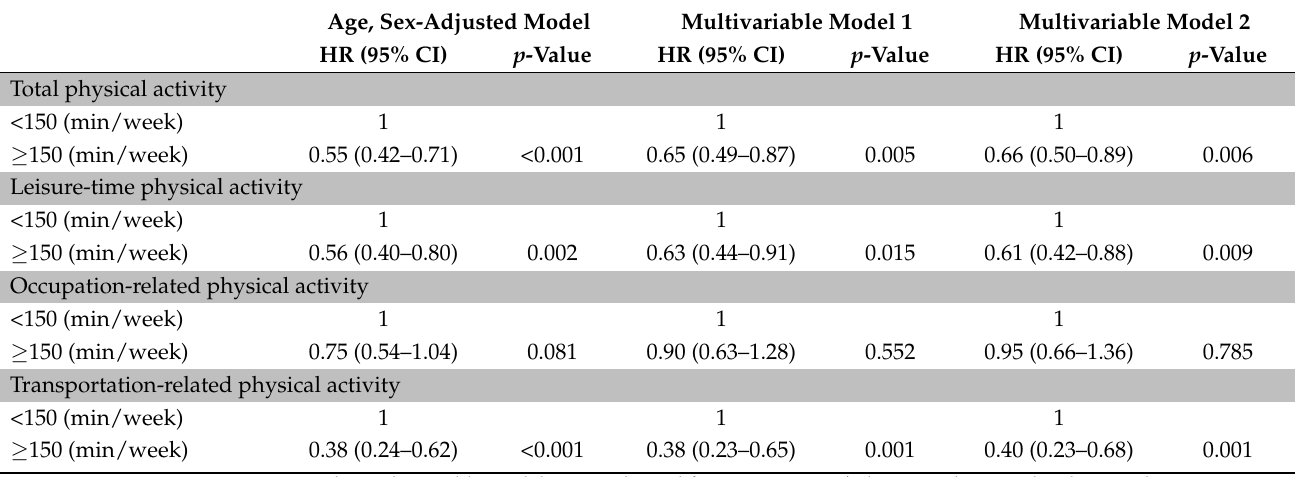
Table 4. Multivariable Hazard Ratio for Cardiovascular Mortality based on the Meeting Physical Activity Guideline among Individuals with NAFLD as defined by the Hepatic Steatosis Index. Age, Sex-Adjusted